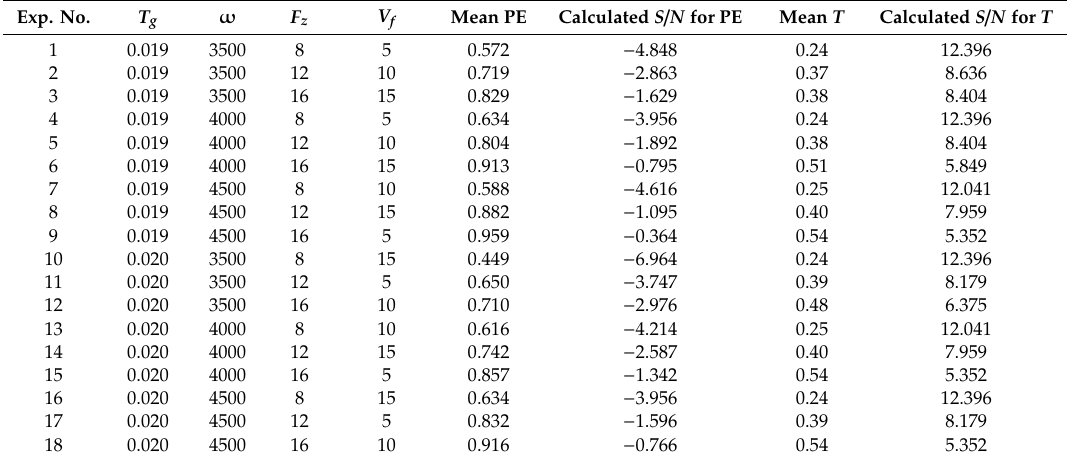
Table 3. Experimental results L 18 ( 2 1 × 3 3 ) for polishing e ffi ciency, and torque.